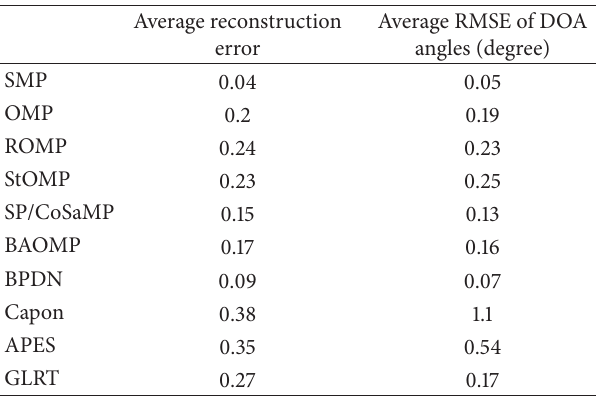
Table 1: Performance